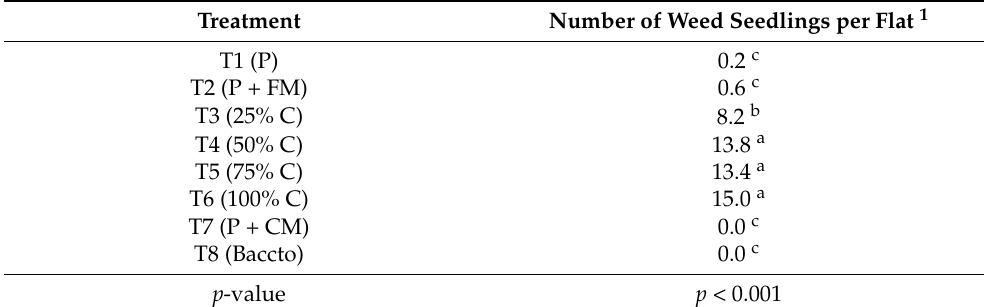
Table 4. Effect of different potting media treatments on the weed pressure, 45 days following seeding ( n = 5).